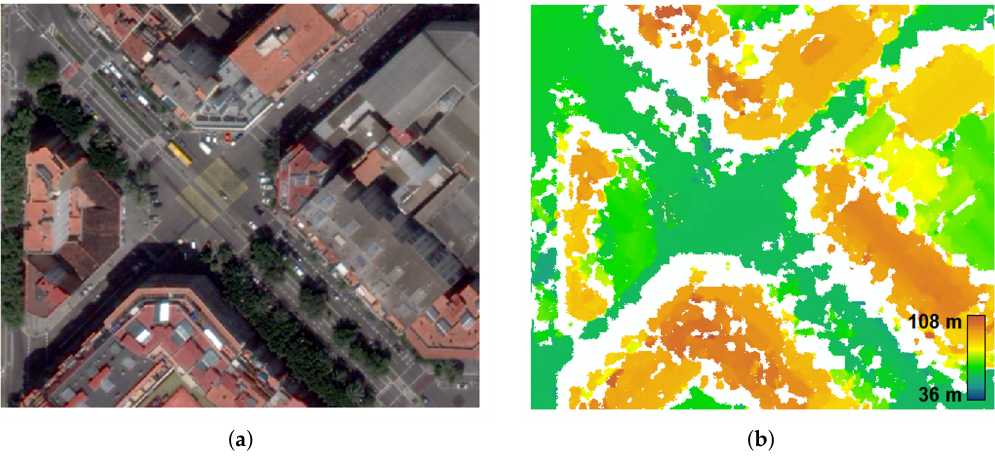
Figure 12. Example of moving objects, shadowing, occlusions effects and parked cars not being reconstructed: ( a ) pansharpened WV-3 image and ( b ) corresponding Digital Surface Model